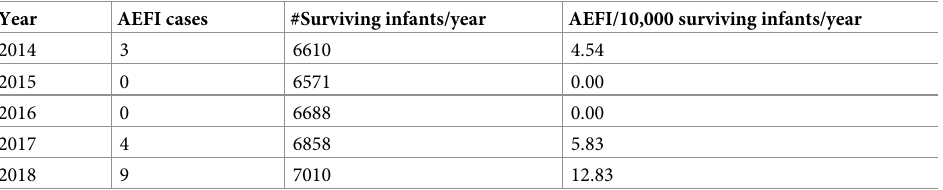
Table 4. Annual performance on AEFI reporting in Ga East Municipality,